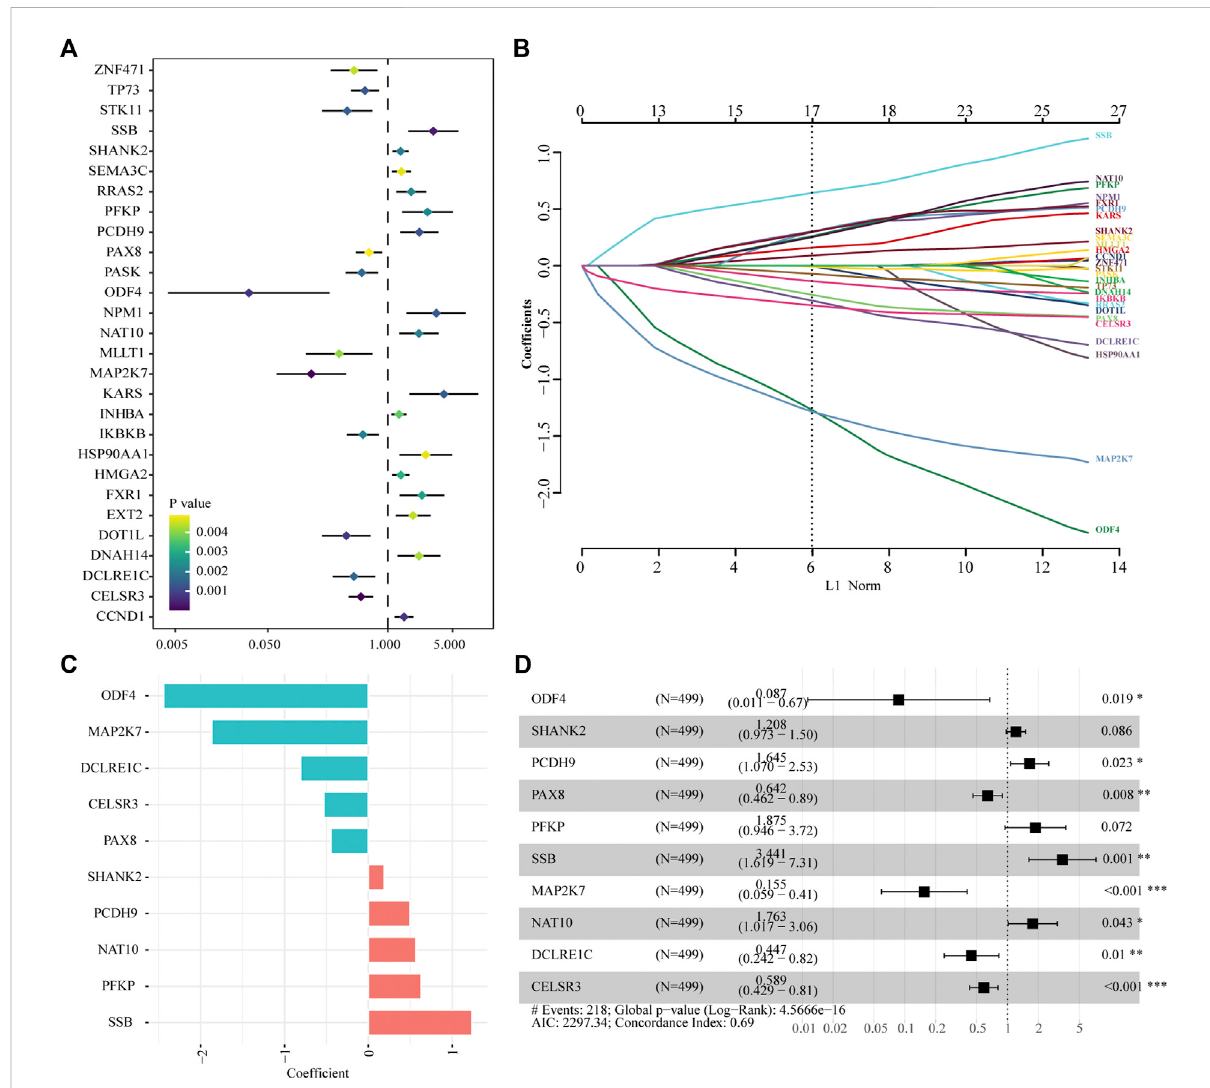
FIGURE 2 Identi fi cation of tumor driver genes in TCGA cohort. (A) Univariate Cox regression analysis to identify prognostic genes. (B) LASSO regression analysis to eliminate collinearity. (C) Coef fi cients of the 10 genes included in the signature. (D) Multivariable Cox proportional-hazards regression analysis of the 10 prognostic